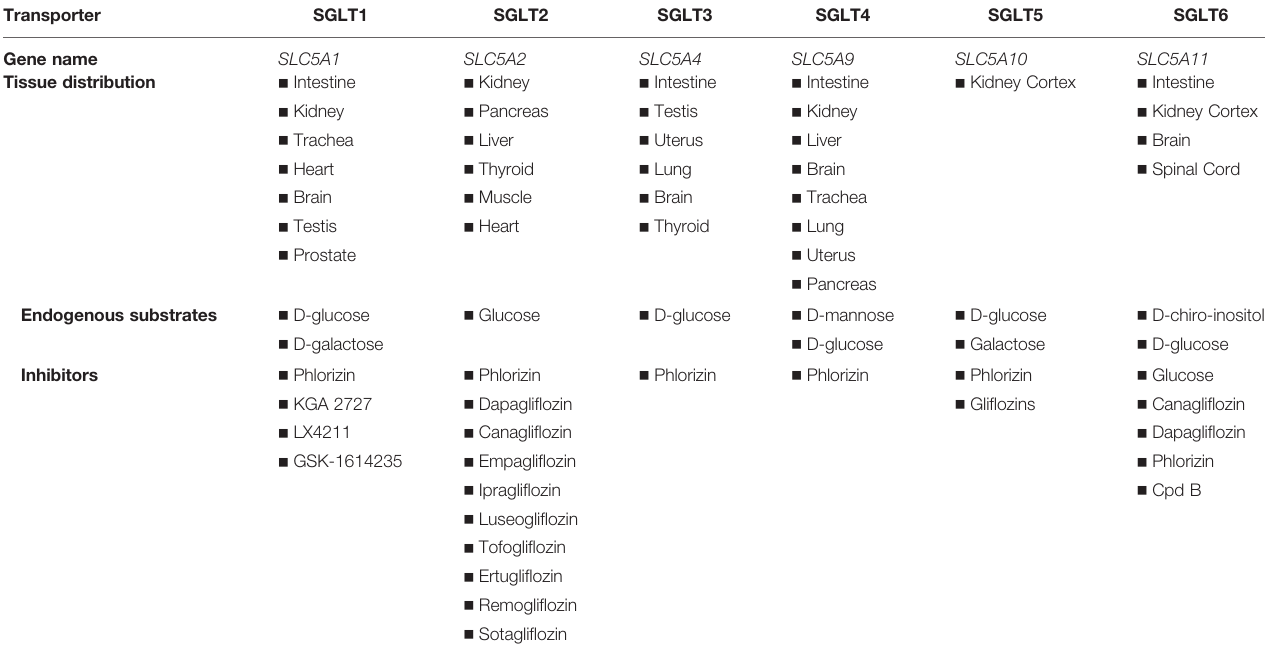
TABLE 1 | Expression of different SGLT isoforms in various mammalian organ systems and their selective inhibitors.